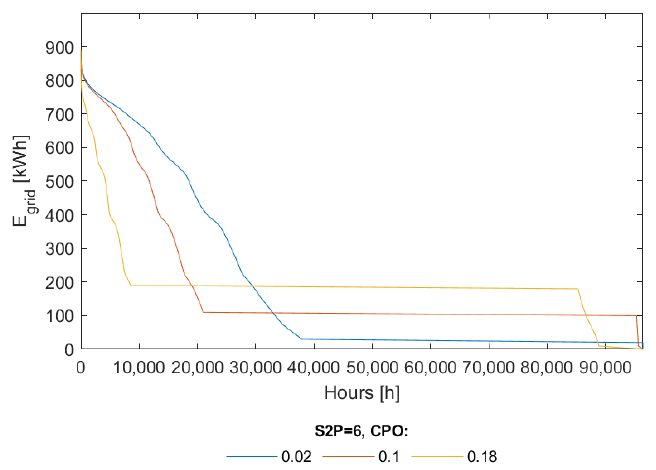
Figure 8. Generation duration curves with fixed S2P, varying CPO factor.